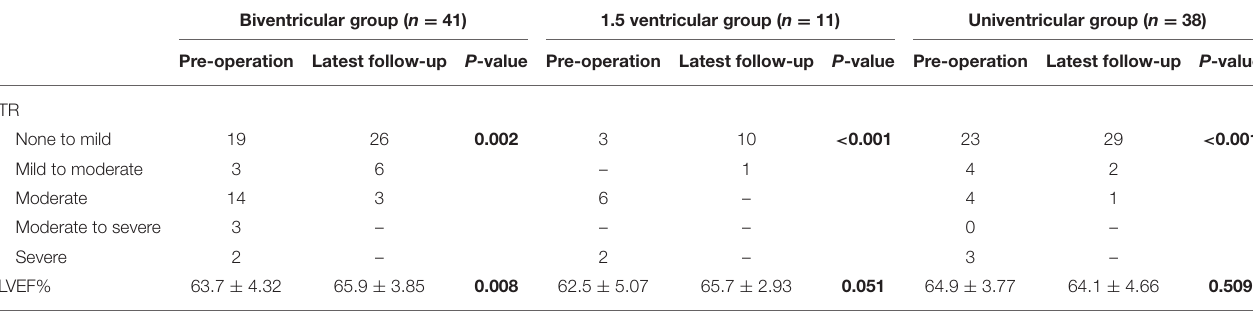
TABLE 4 | Tricuspid regurgitation and cardiac function of the three groups comparing preoperative and last follow-up data. Biventricular group ( n = 41) 1.5 ventricular group ( n =